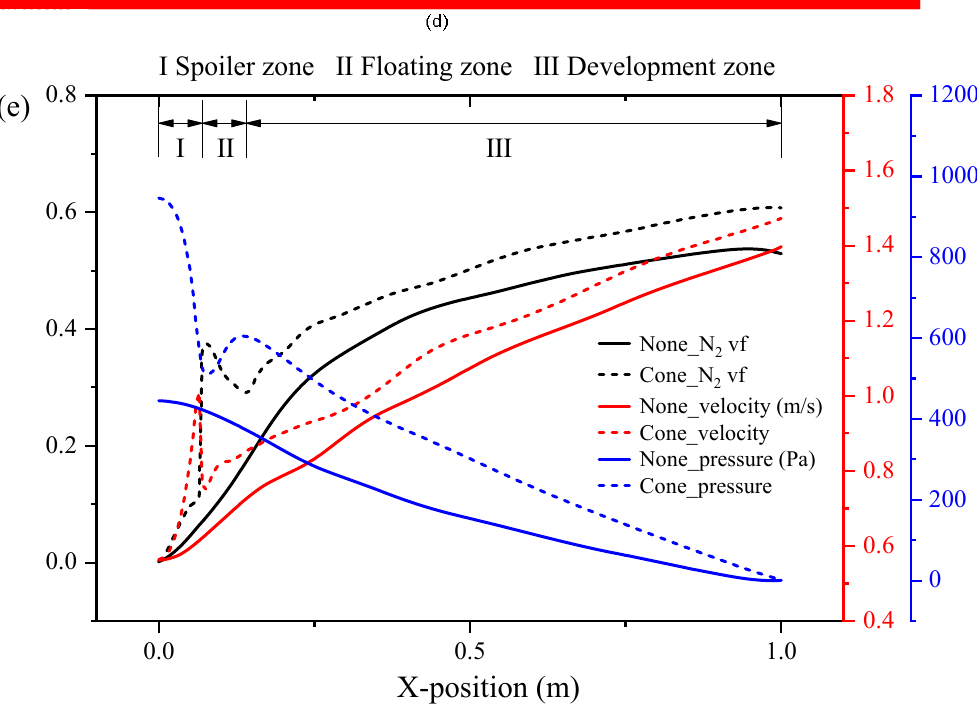
Figure 3. The N 2 volume fraction and temperature distributions of Case 0 and Case 1-1 at Z = 0 mm and outlet positions ( a – d ), and their quantitative distributions of N 2 volume fraction, velocity, and pressure at X-positions ( e